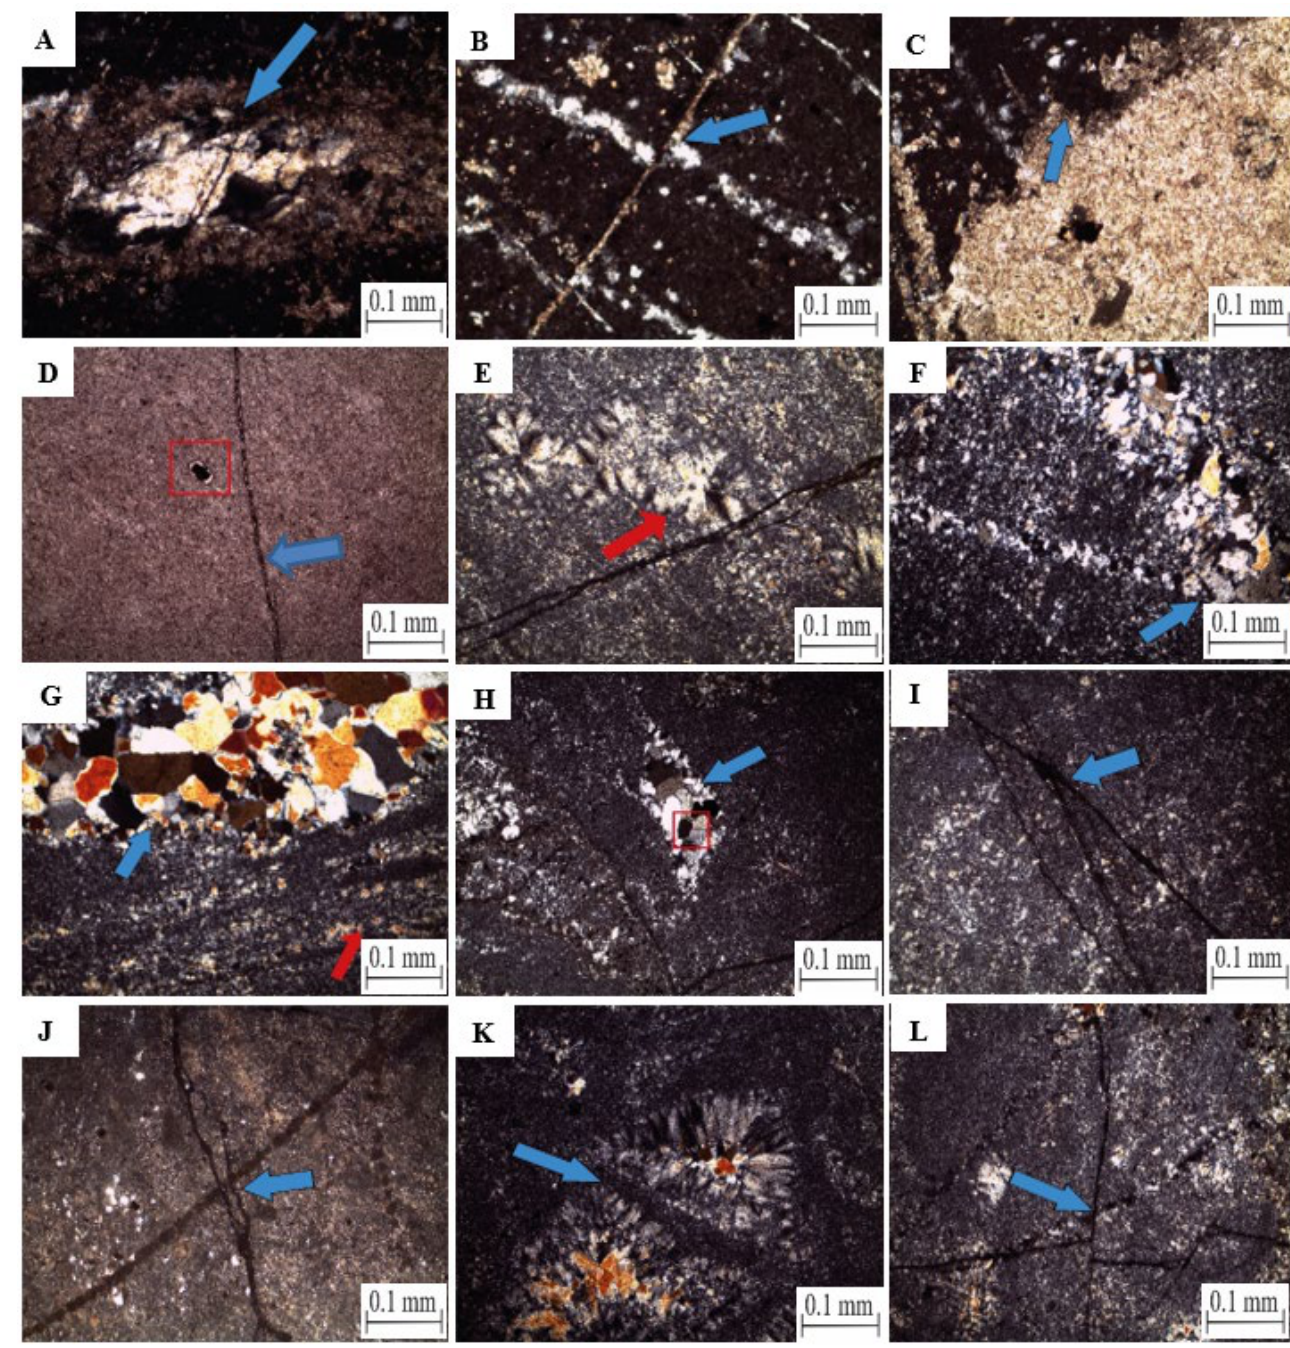
Figure 7. Photomicrographs of the Dol. II microfacies of the Abbottabad Formation. ( A ) Chert inclusion in dolomite vein (blue arrow) of cherty dolomite (KA-5; PPL. 10 × ). ( B ) Dolomite vein cutting chalcedony (blue arrow) (KA-5; XPL. 10 × ). ( C ) Irregular contact of dolomite and chert (blue arrow) (KA-5; XPL. 10 × ). ( D ) Dolomitized veins highlighted by hematite (blue arrow) and rectangle showing apatite (KA-41, PPL. 4 × ). ( E ) Chalcedony (red arrow) and hematite vein (KA-41; XPL. 4 × ). ( F ) cross cutting cherty veins (blue arrow) in cryptocrystalline silica (KA-41; XPL. 4 × ). ( G ) Microcrystalline (red arrow) and cryptocrystalline chert (blue arrow) (KA-41; XPL. 4 × ). ( H ). Chert nodule (blue arrow) containing pyrite (KA-59; XPL. 4 × ). ( I ) Hematite veins (blue arrow) in microcrystalline silica (KA-59; XPL. 4 × ). ( J ) Hematite veins cut by bioclast (KA-60; XPL. 4 × ). ( K ) Chalcedony (blue arrow) (KA-61; XPL. 4 × ). ( L ) Unfilled veins showing micro faults (blue arrow) (KA-61; XPL. 4 ×